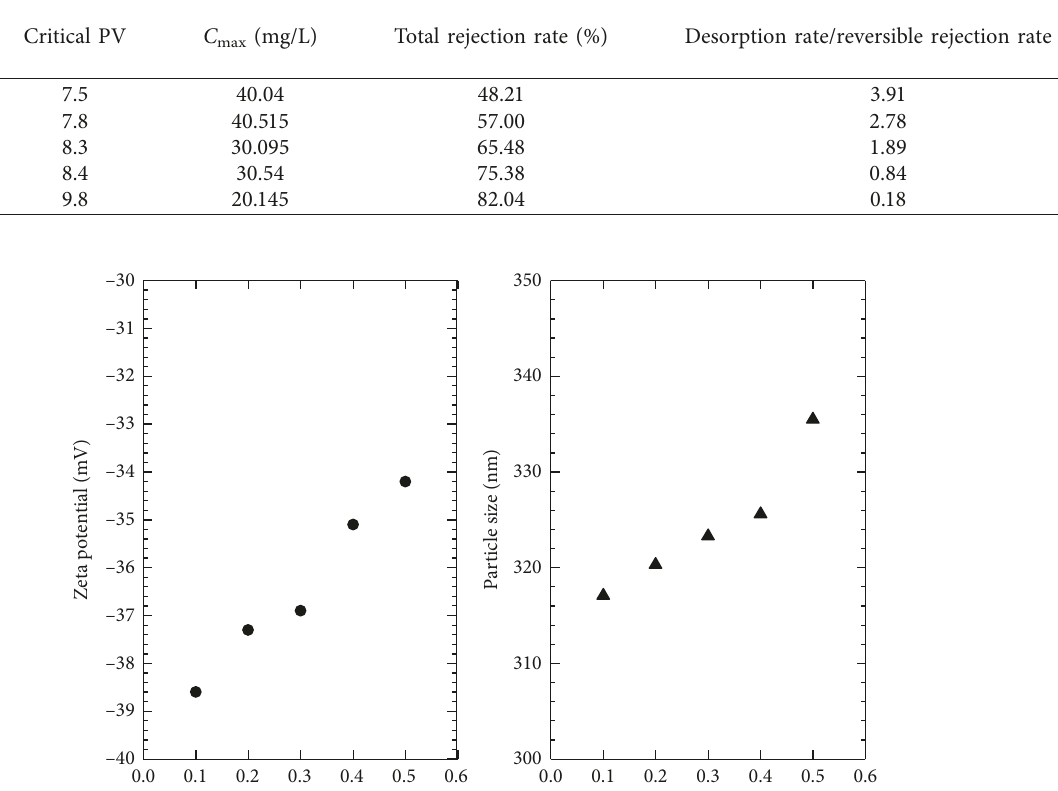
Table 5: Parameters of the BTC.